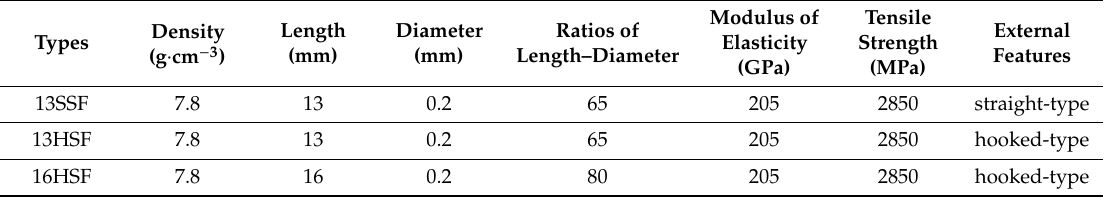
Figure 2. Steel fiber types: ( a ) 13SSF, ( b ) 13HSF and ( c ) 16HSF. Table 2. Physical and mechanical properties of the steel